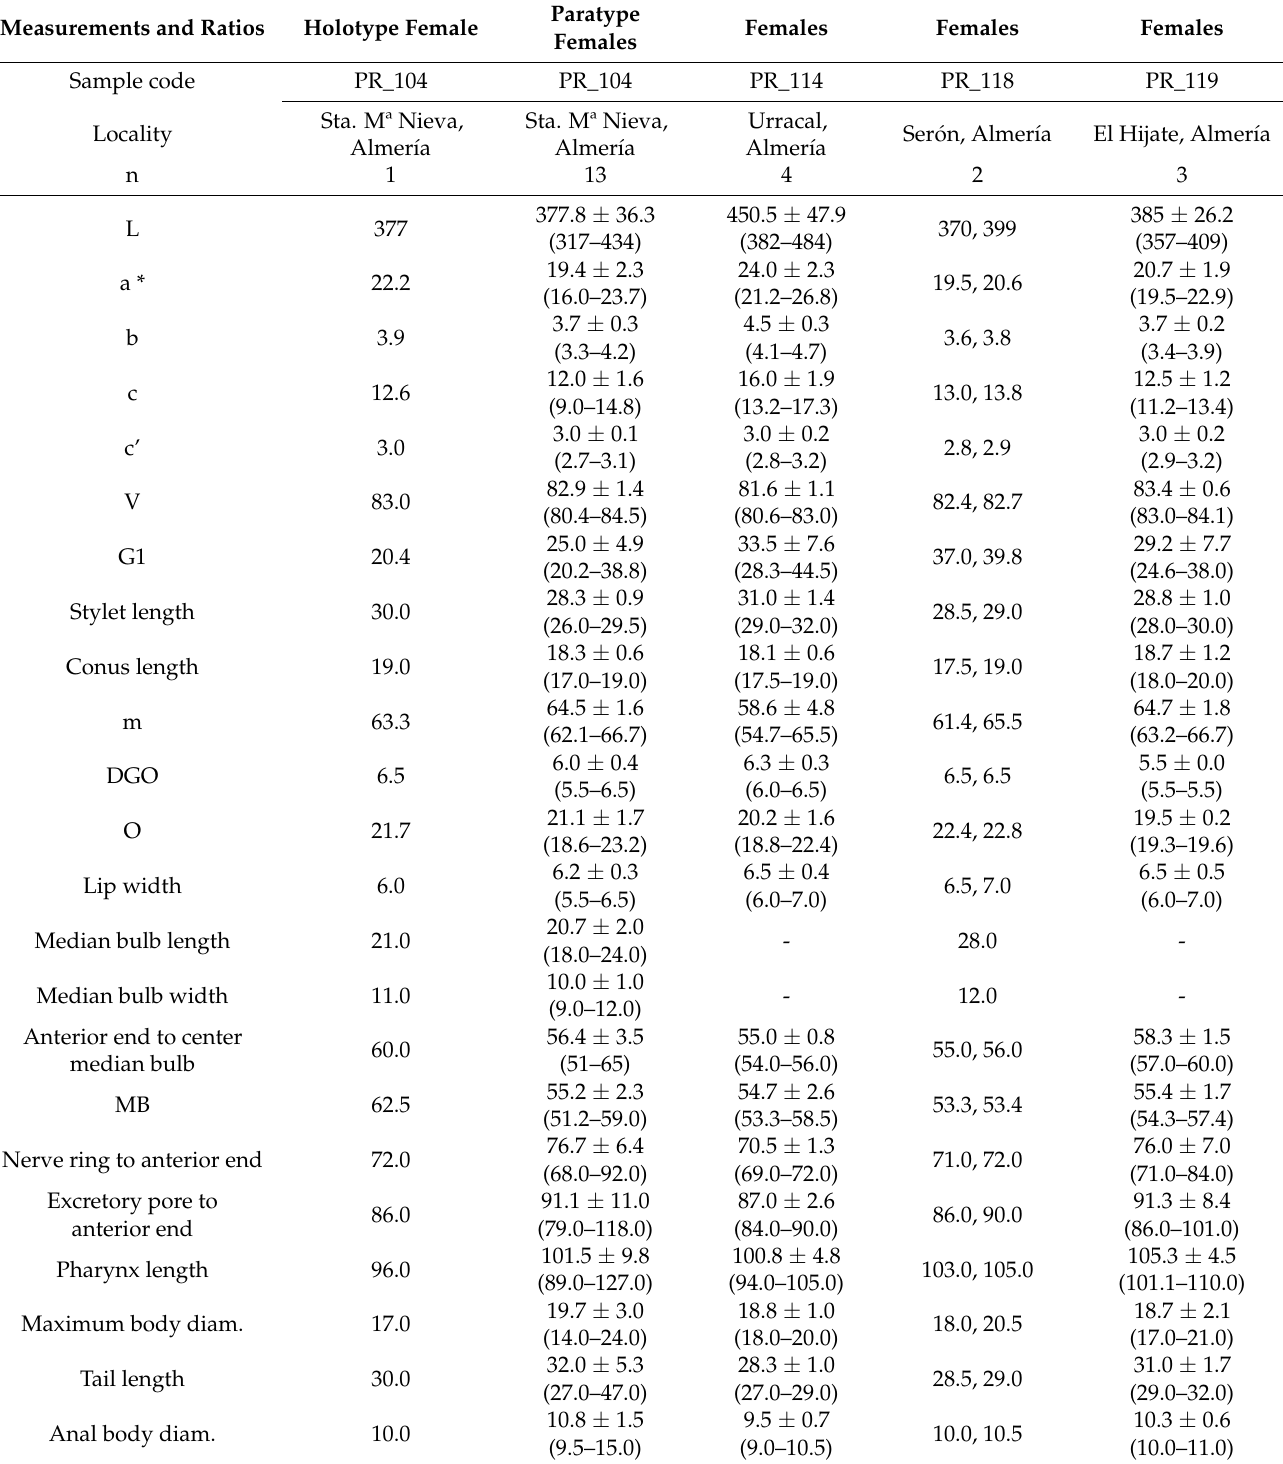
Table 3. Morphometrics of Paratylenchus indalus sp. nov. paratype females and other populations from Spain. All measurements are in µ m and in the form: mean ± s.d.